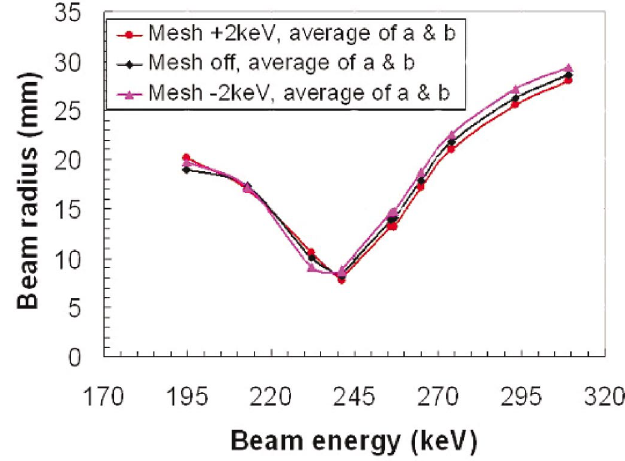
FIG. 18. (Color) A cylindrical metal mesh inside the beam pipe in the magnetic final-focus section.